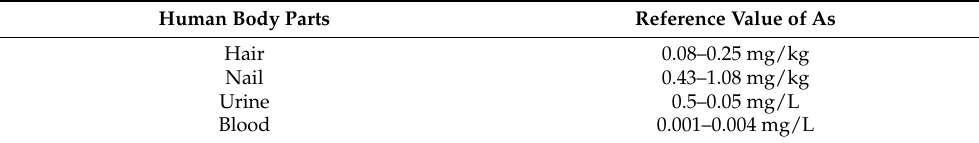
Table 12. Normal arsenic values in different parts of human body [118].